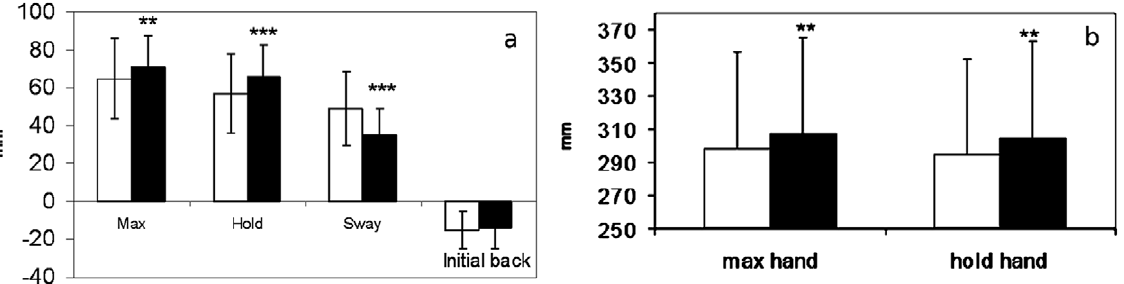
Figure 4. Mean forward displacement of the COP and dominant hand on elevated surface. (a) Mean forward movement of the COP on a 1 m elevated surface in no touch (white) and touch (black) conditions for variables: Max - forward displacement of the CoP, Hold – average position of the COP in the end position that lasted 2 seconds; Sway - of the COP during a 2 second hold of the reach expressed as path length, Initial back - initial backward displacement of the COP during reach).(b) Mean movement of the hand during the reaching movement in the no touch (white) and touch (black) conditions. The significant differences are marked as **p , 0.01; ***p , 0.001.